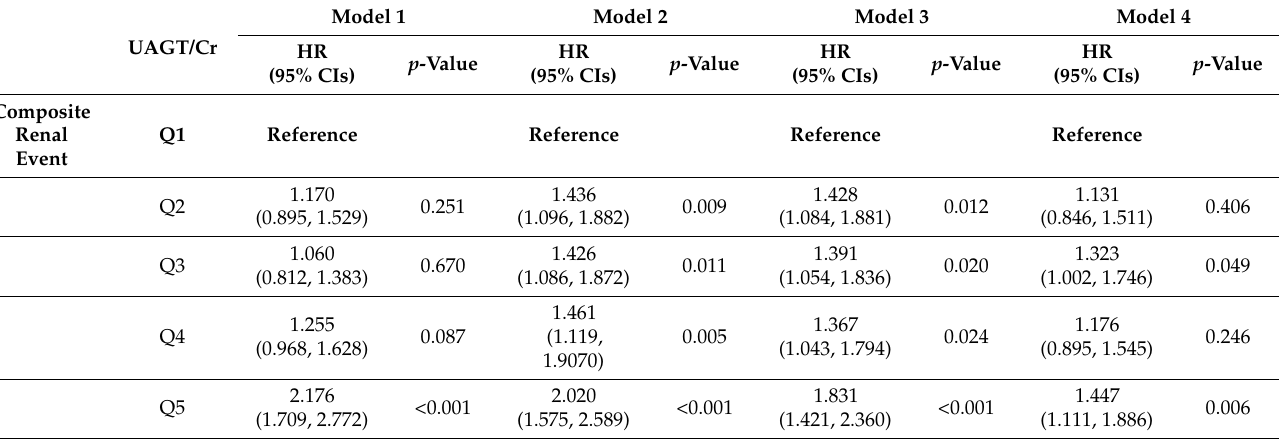
Table 4. HRs for composite renal event by UAGT/Cr level using a multiple